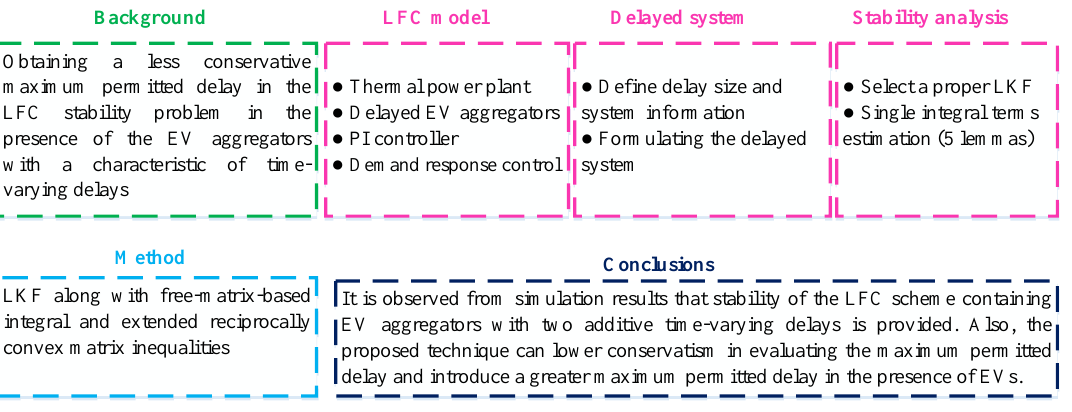
Figure 1. Schematic of the proposed strategy for the delay-dependent stability analysis.